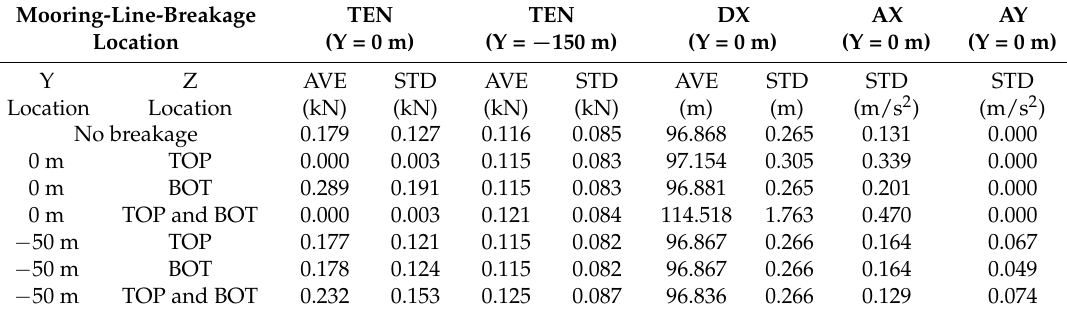
Table 6. Statistical data of mooring tension, surge motion of the location buoy, and acceleration of the net assembly in the X and Y directions in different mooring-line-breakage scenarios at H s = 3.0 m, T p = 8.0 s, and current velocity = 0.6